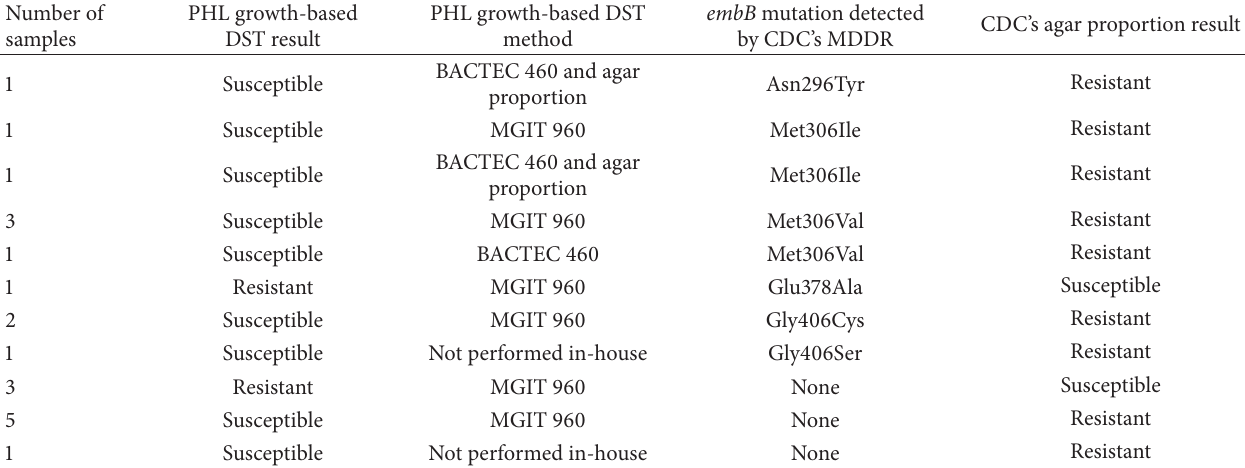
Table 3: Summary of 20 discordant results for detection of EMB resistance between PHL and